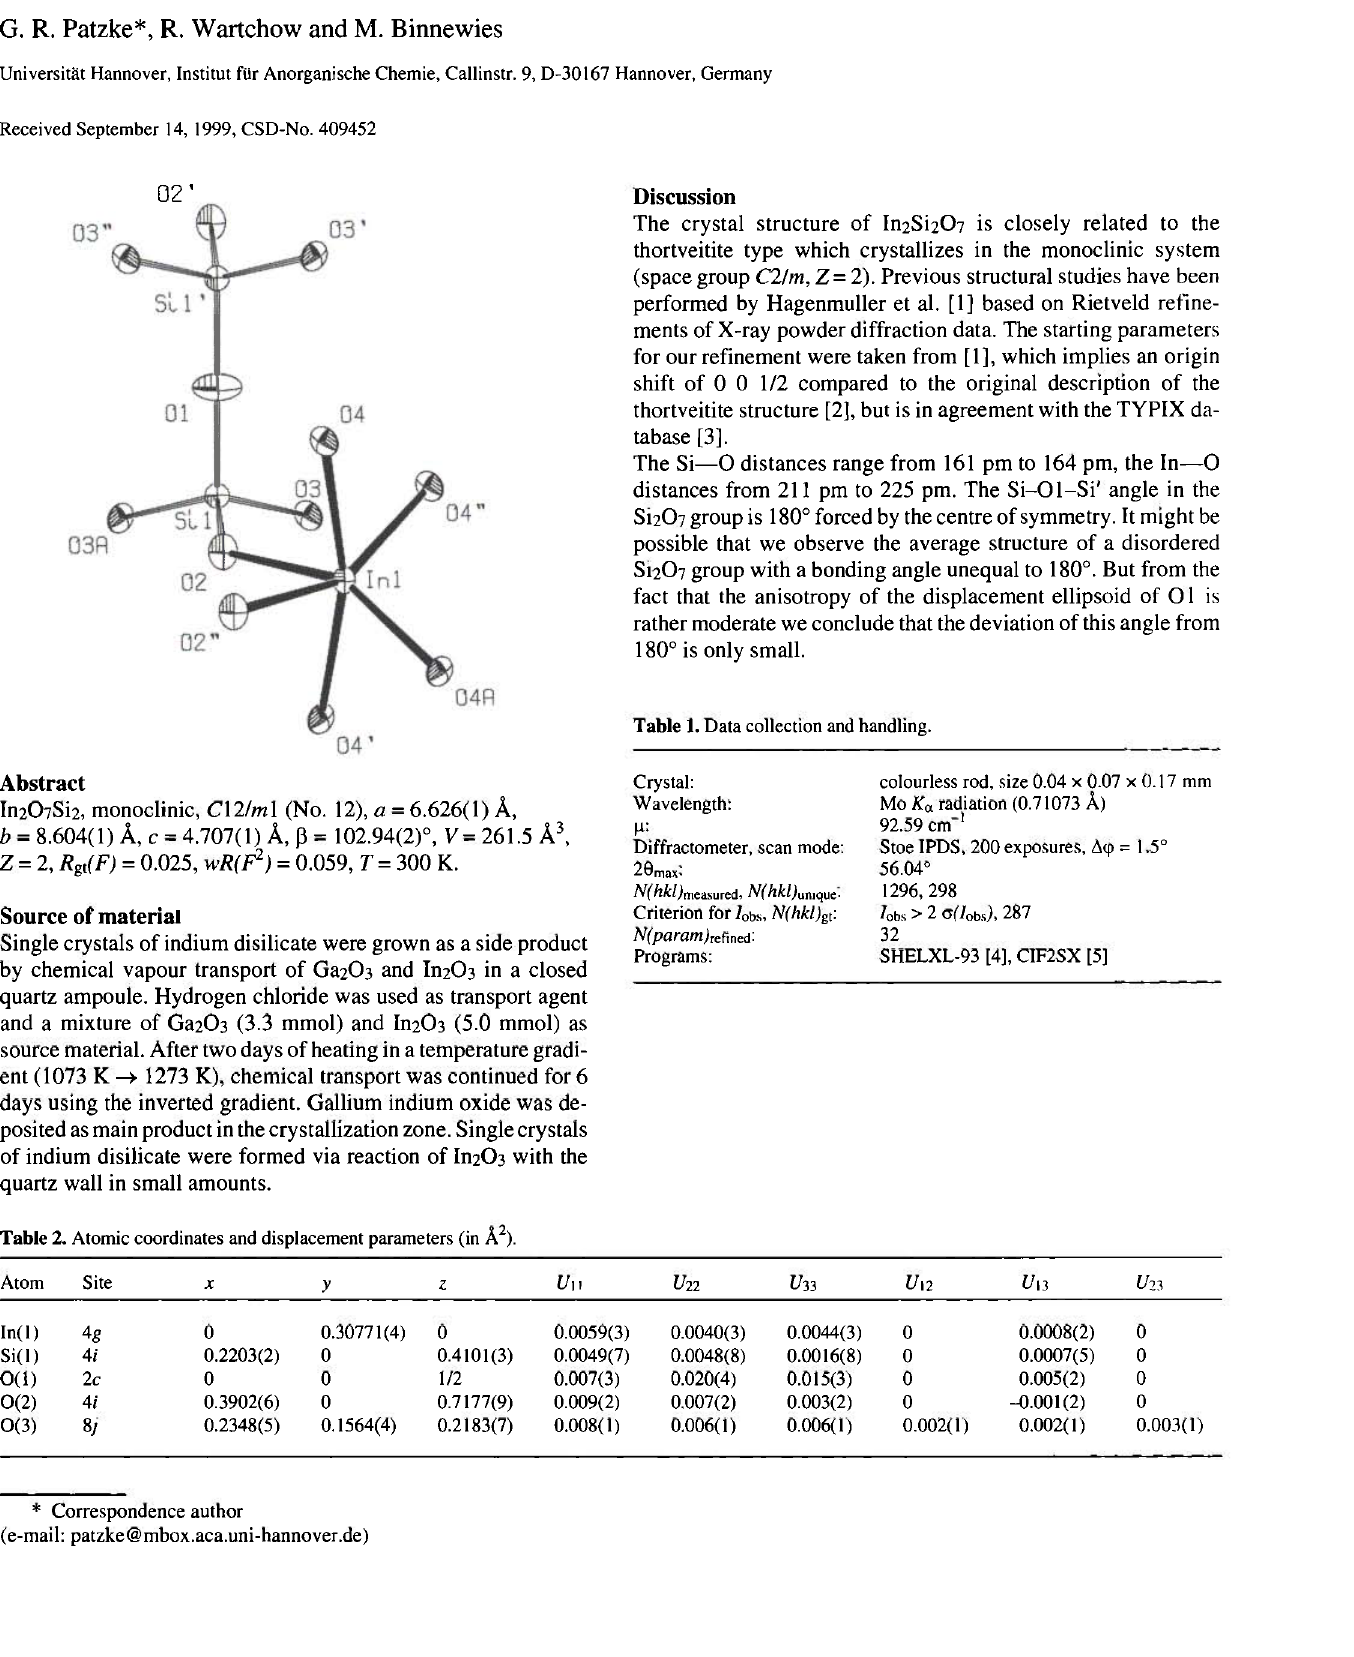
Table 2. Atomic coordinates and displacement parameters (in A 2 ). Atom